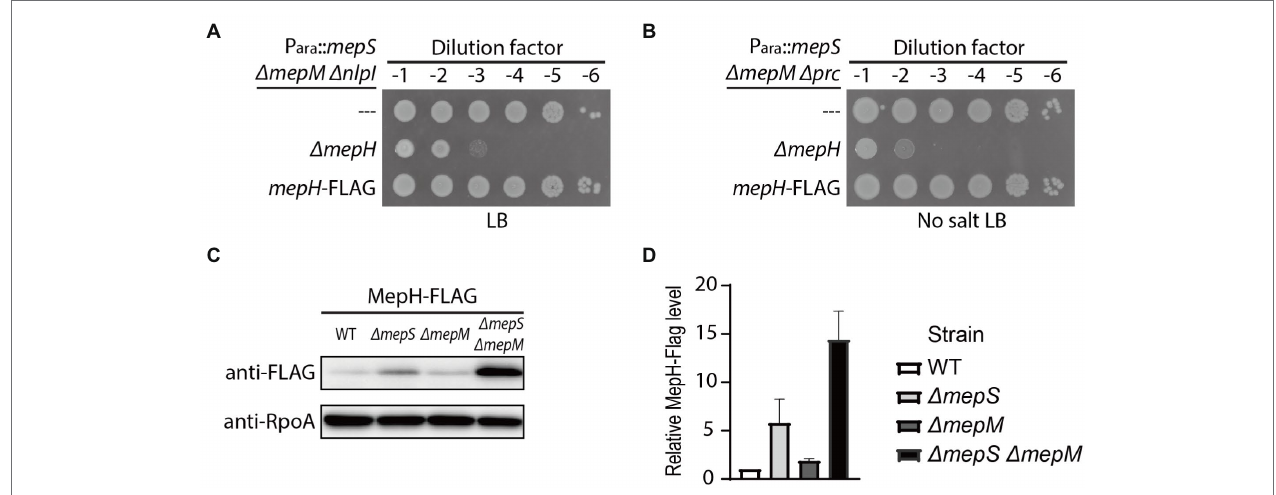
FIGURE 5 | MepH levels increase in the Δ mepS Δ mepM strain. (A,B) Spot dilution assay to assess the functionality of MepH-FLAG. (A) The growth phenotype of WJ126 (P ara :: mepS Δ mepM Δ nlpI mepH -FLAG) was compared with that of WJ76 (P ara :: mepS Δ mepM Δ nlpI ) and WJ95 (P ara :: mepS Δ mepM Δ nlpI Δ mepH ) by incubation on LB agar for 22 h at 30 ° C. (B) The growth phenotype of WJ125 (P ara :: mepS Δ mepM Δ prc mepH -FLAG) was compared with that of WJ81 (P ara :: mepS